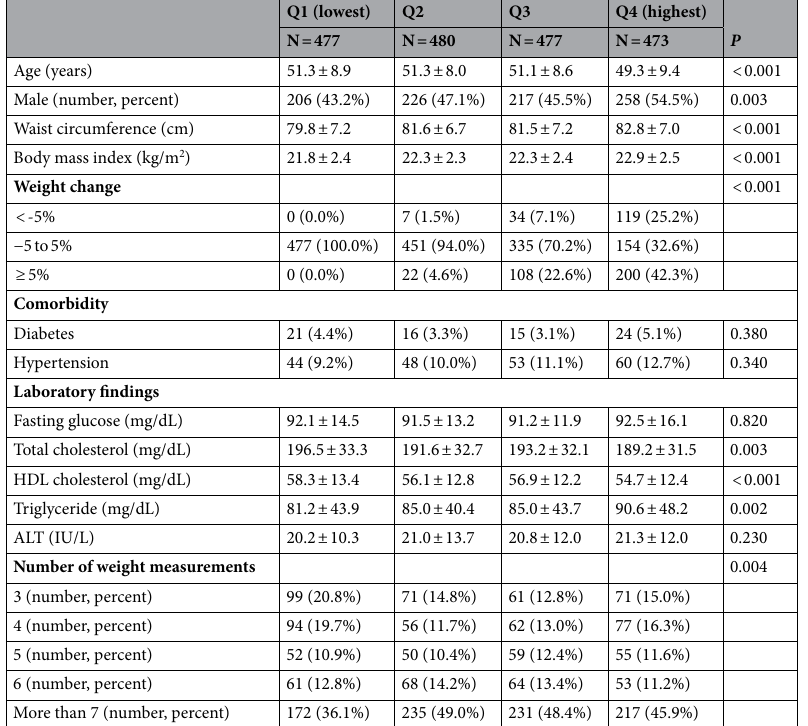
Table 1. Baseline characteristics of the study population according to quartiles of weight variability. Data are presented as mean ± standard deviation for continuous variables and n (%) for categorical variables. Q quartile, HDL high density lipoprotein, ALT alanine